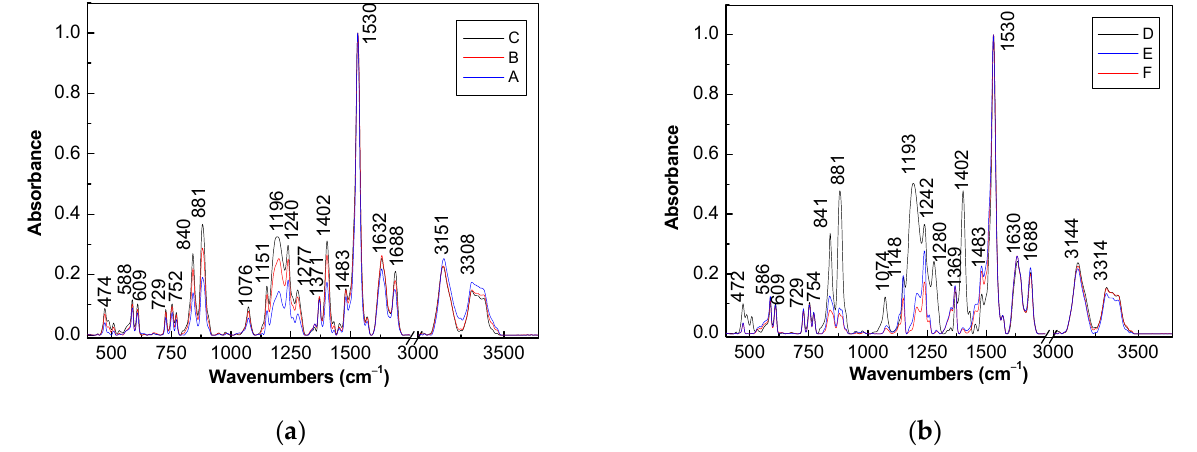
Figure 5. IR spectra of the samples labeled as samples A (black curve, a ), B (red curve, a ), C (blue curve, a ), D (black curve, b ), E (blue curve, b ) and F (red curve, b ).